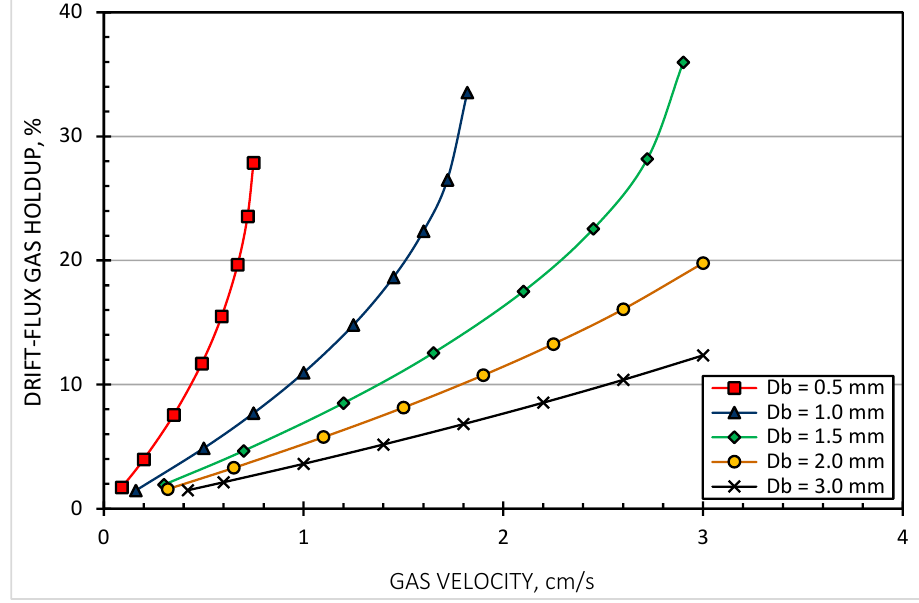
Figure 1. Gas holdup predictions for selected bubble sizes and gas velocities (drift-flux model).